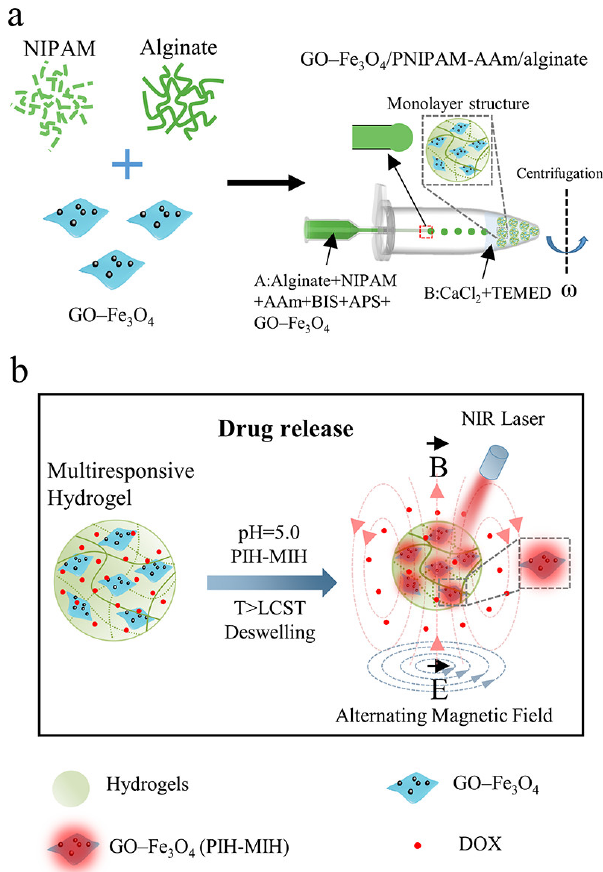
Figure 7. Schematic illustration of GO − Fe 3 O 4 /PNIPAM-AAm/alginate nanocomposite hydrogel microcapsules for controlled drug release. ( a ) Schematic diagram of the fabrication of GO − Fe 3 O 4 /PNIPAM-AAm/alginate NCH microcapsules based on the centrifugal microfluidic method. ( b ) GO − Fe 3 O 4 /PNIPAM-AAm/alginate NCH microcapsules for NIR light-, magneto-, and pH-responsive drug release. Reprinted with permission [176].